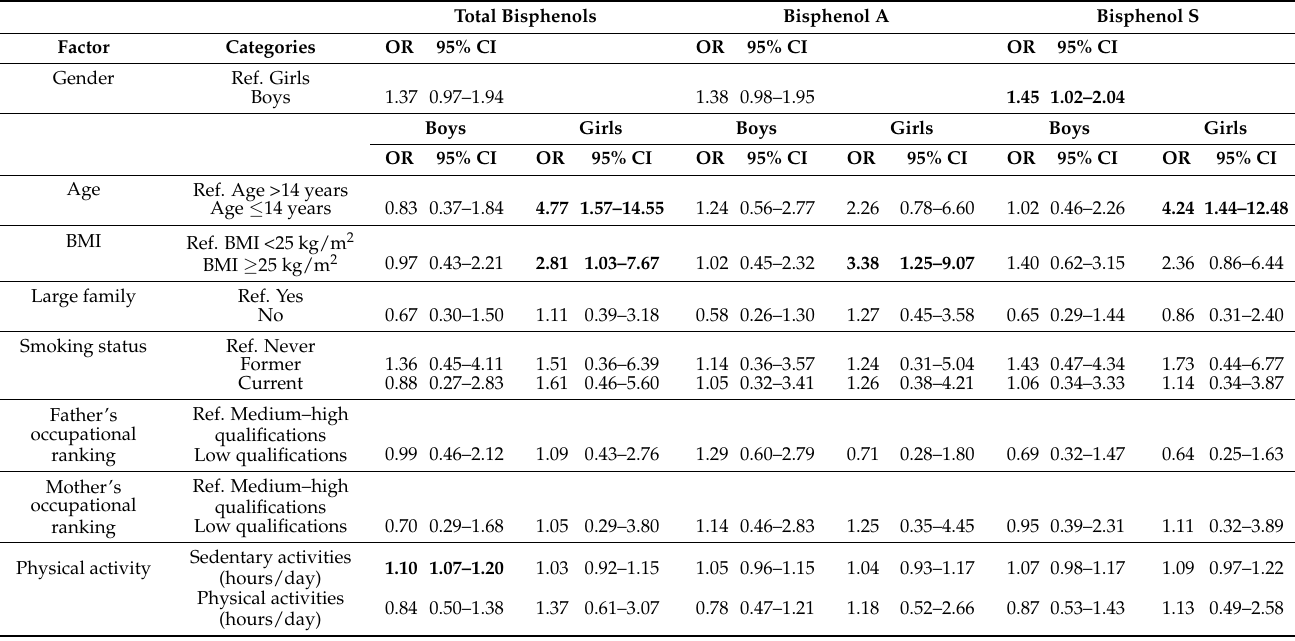
Table 4. The influence of factors on risk of having a high total intake (third tercile) of total bisphenols, bisphenol A, and bisphenol S, according to